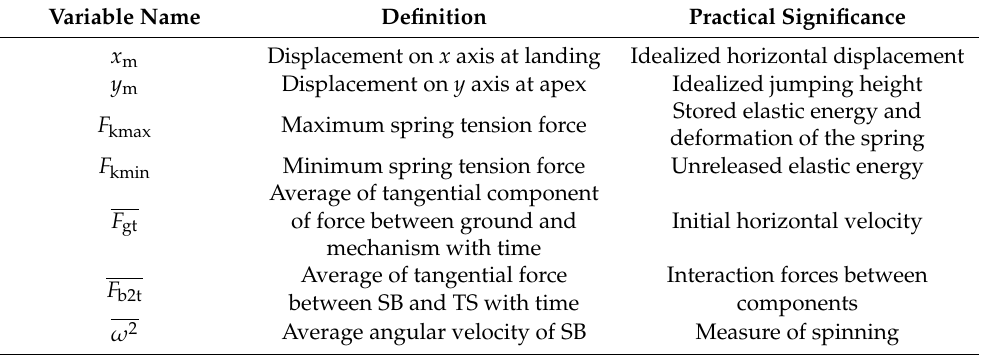
Table 1. Featured Dynamical